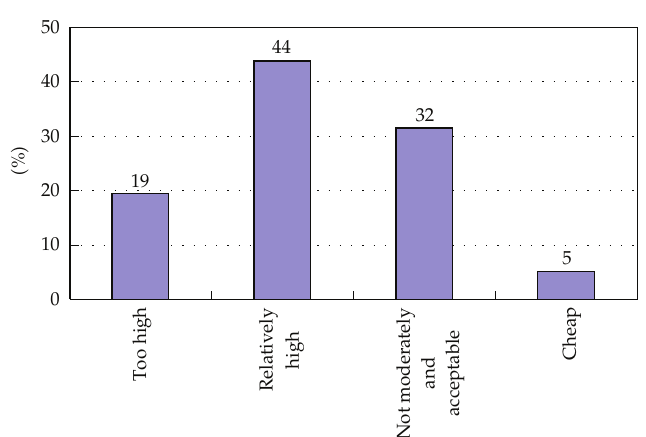
Figure 4: Parking fee at